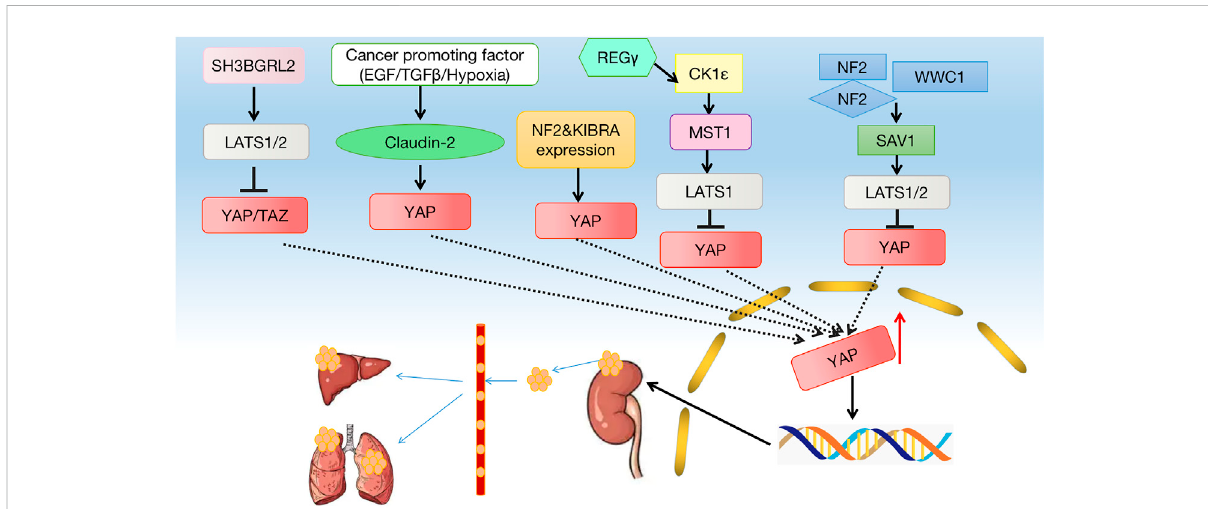
FIGURE 2 Crosstalk betweentheHippo signaling pathway and kidney cancer. Many factors lead to adecrease inphosphorylation ofMST1/2and LATS1/2, whichleadstoadecreaseinphosphorylationofYAP,whichleadstoadecreaseinp-YAPandYAPenteringthenucleus.Thehippopathwaycanaffect cell growth, proliferation, apoptosis, and other factors that contribute to the development of kidney